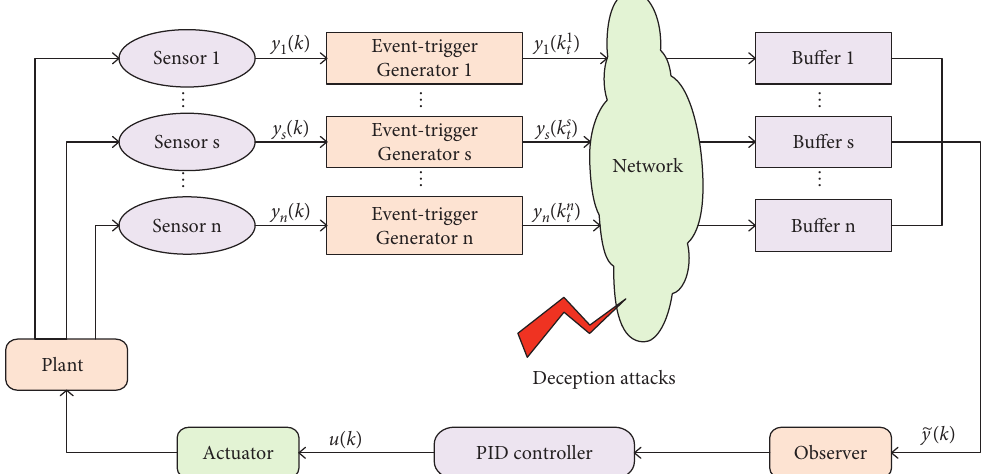
Figure 1: The structure of the T-S fuzzy system under DETM and deception